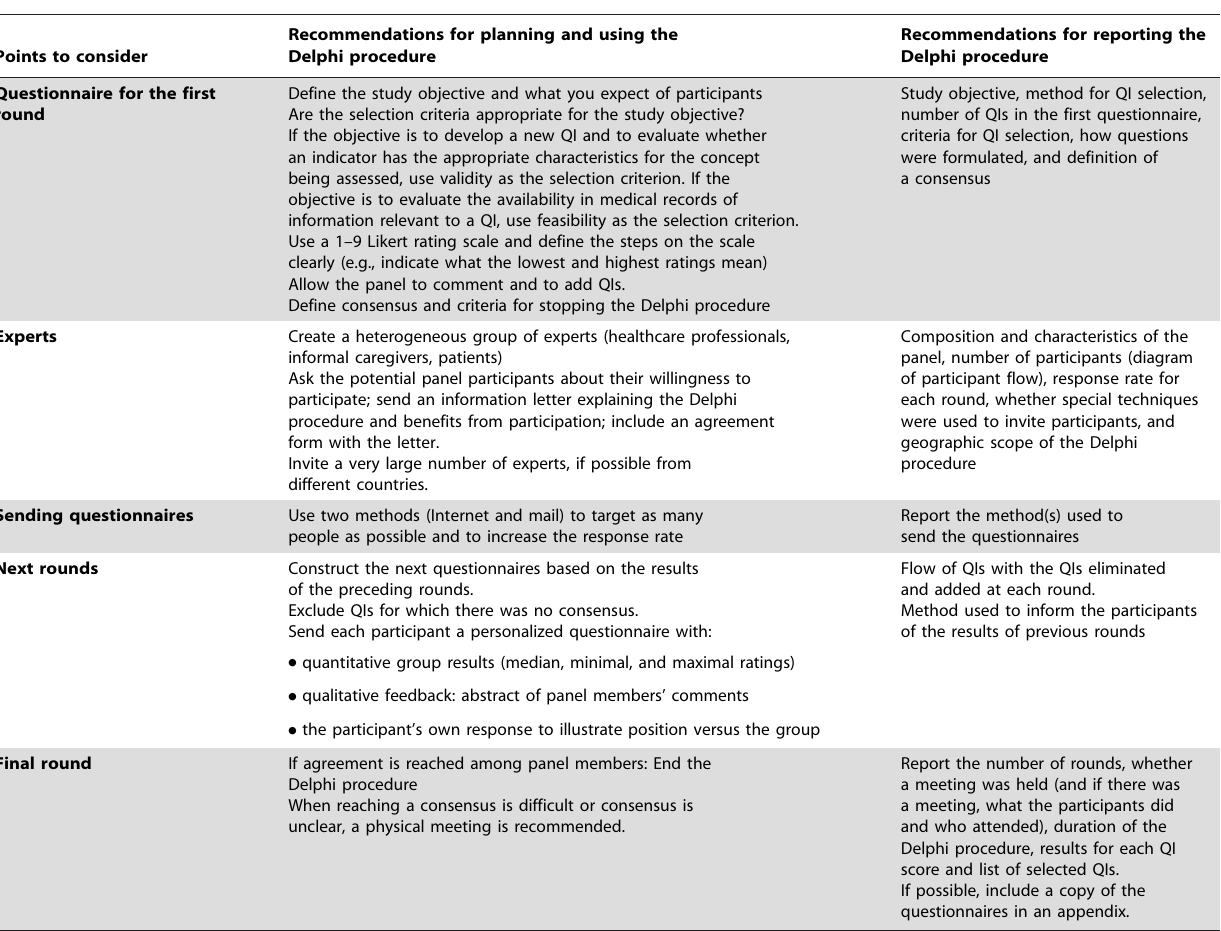
Table 5. Practical guidance for using and reporting Delphi procedures performed to select healthcare quality indicators